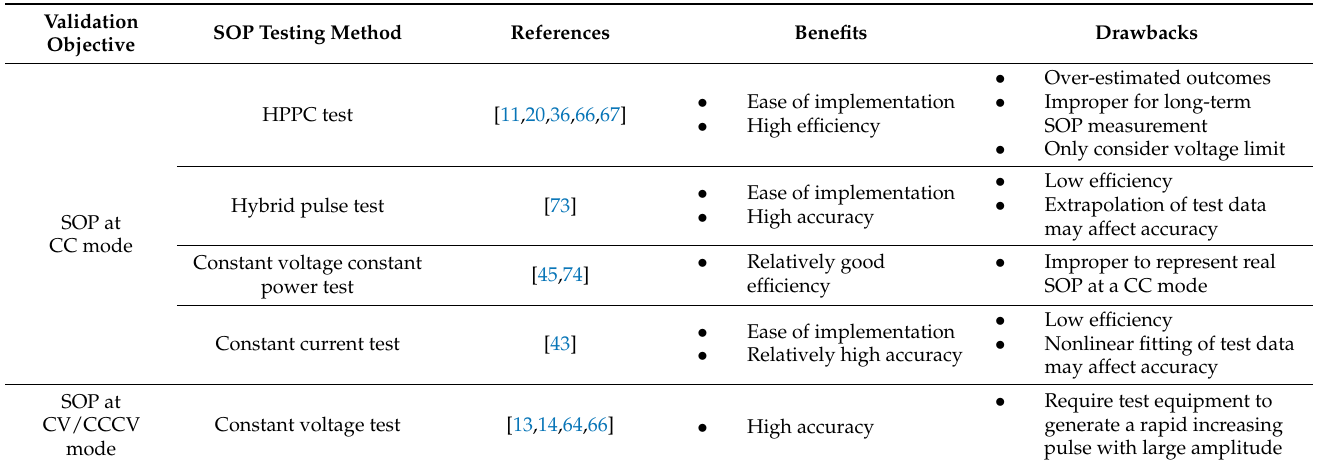
Table 4. Existing SOP testing methods and their benefits and